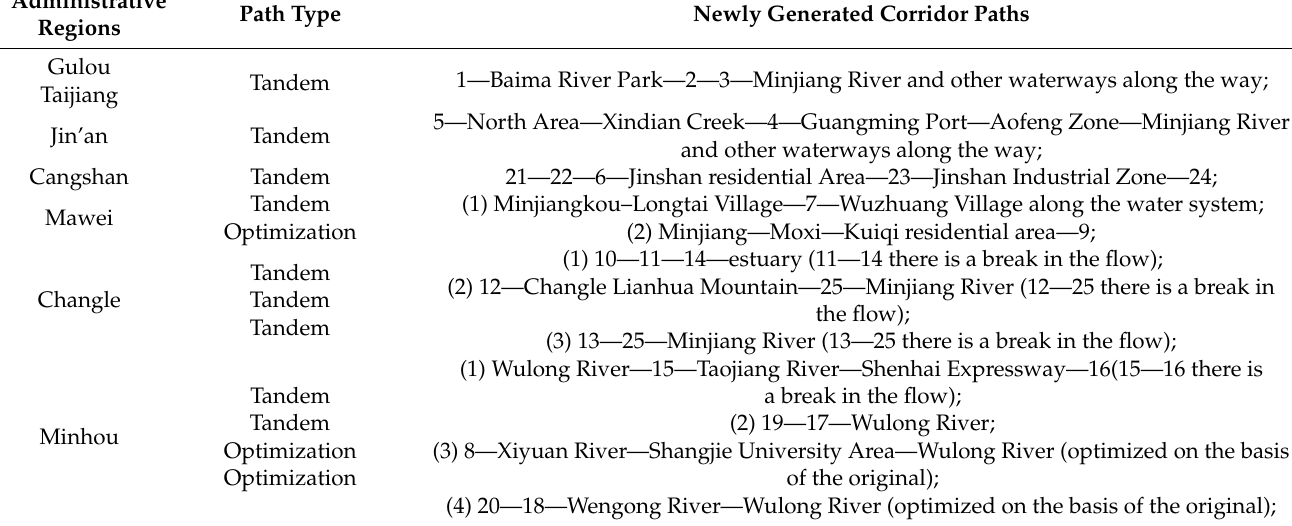
Table 5. Optimized corridor